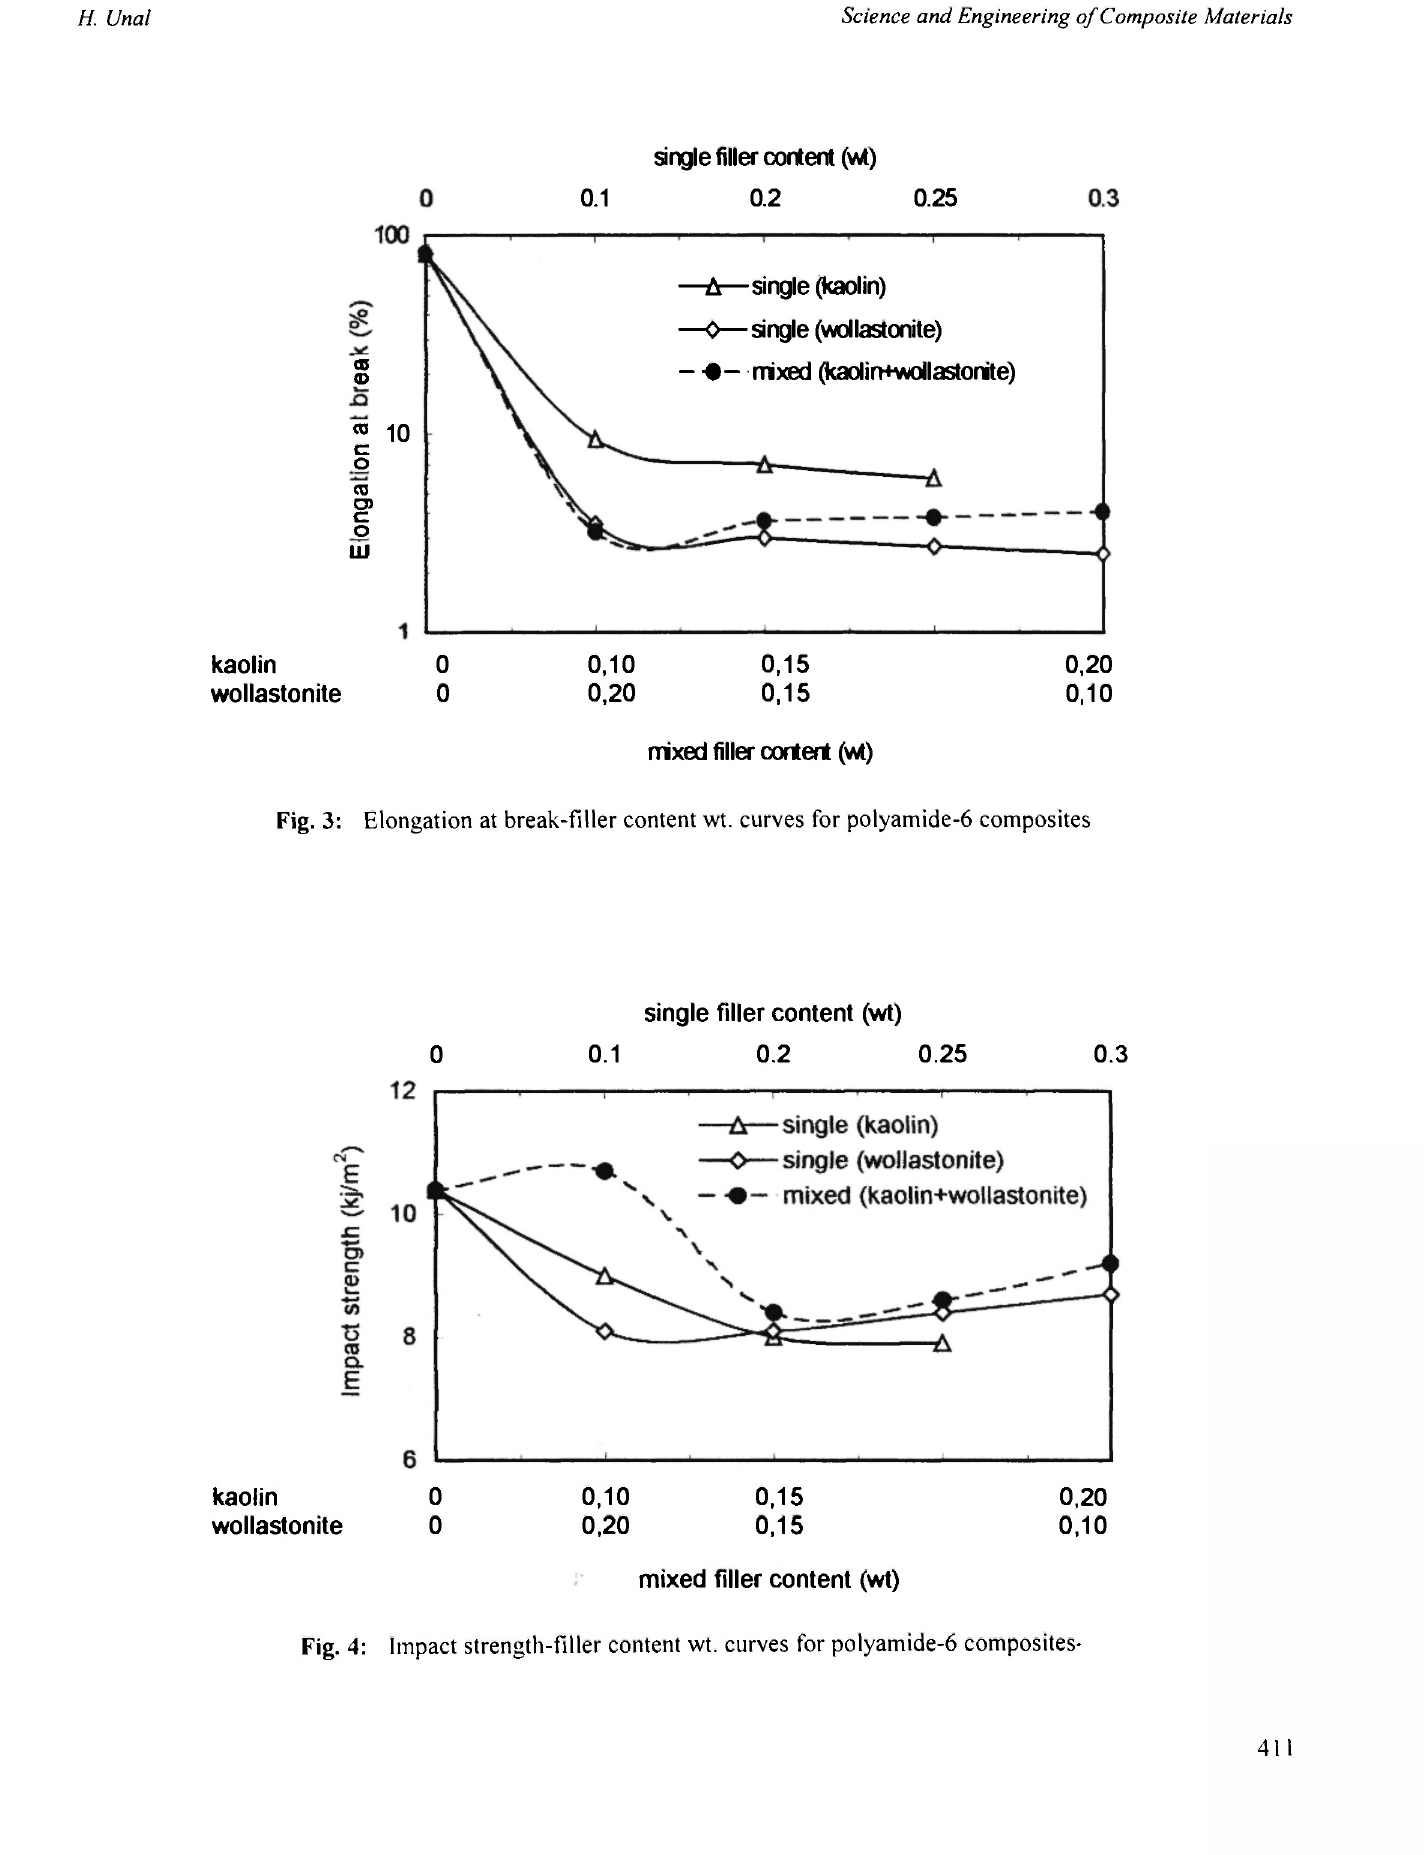
Fig. 4: Impact strength-filler content wt. curves for polyamide-6